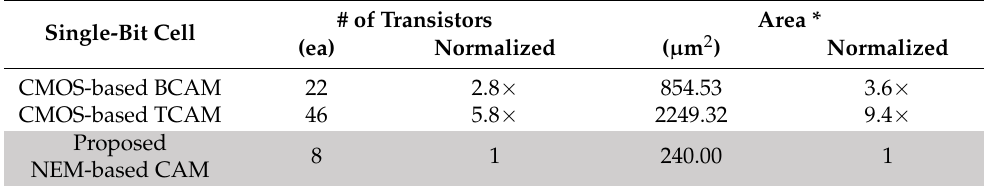
Table 3. Comparison of the number of bit cell transistors and layout area [25].